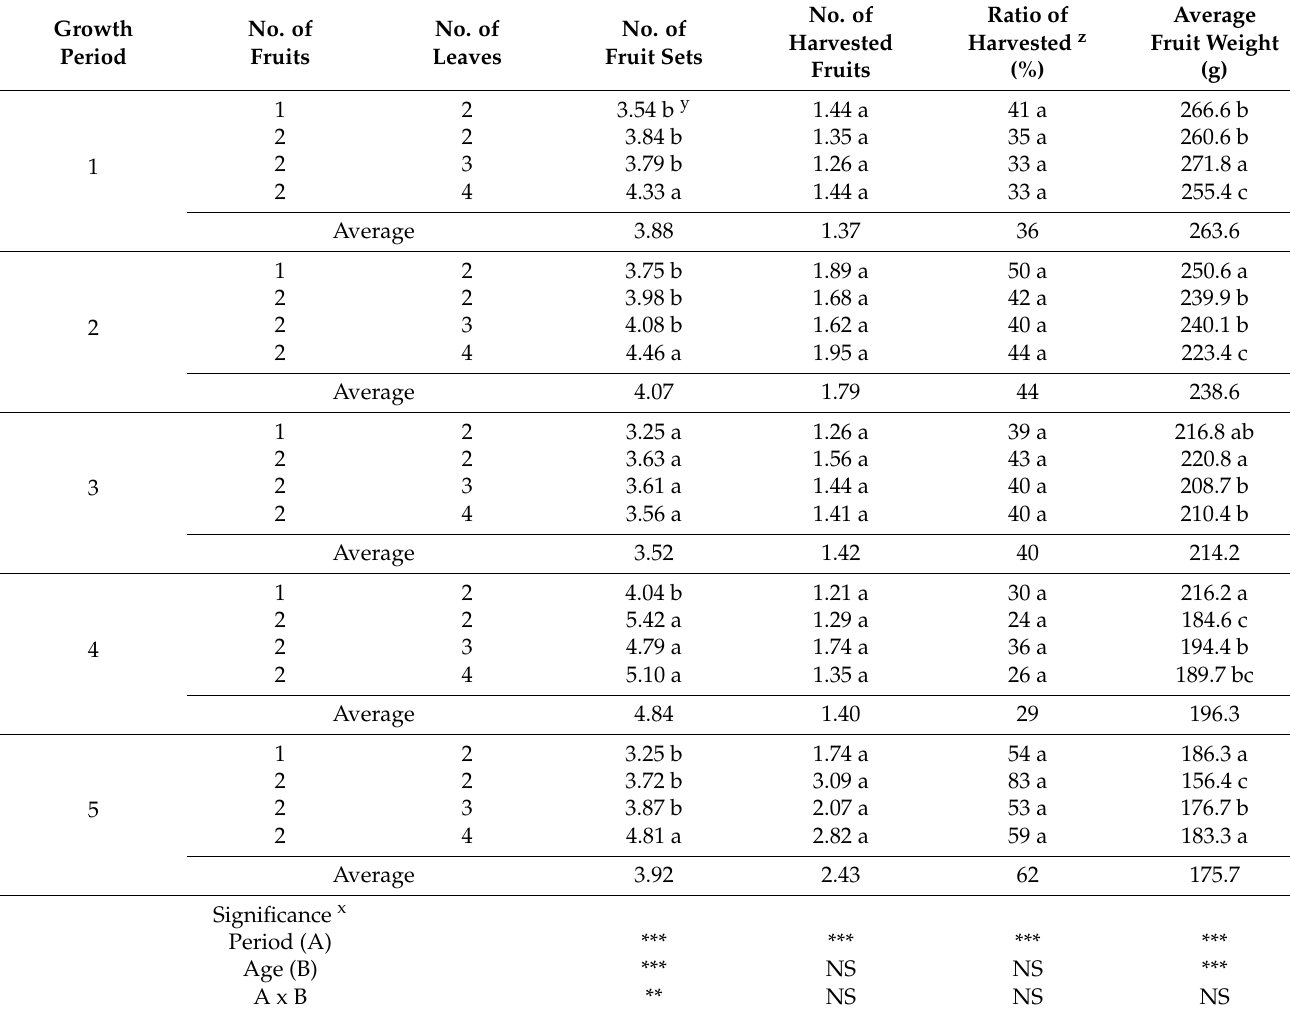
Table 2. Effects of side leaves and flowers on fruit characteristics by growth period of winter-planted and summer-cultivated paprika ‘Redwing RZ’.